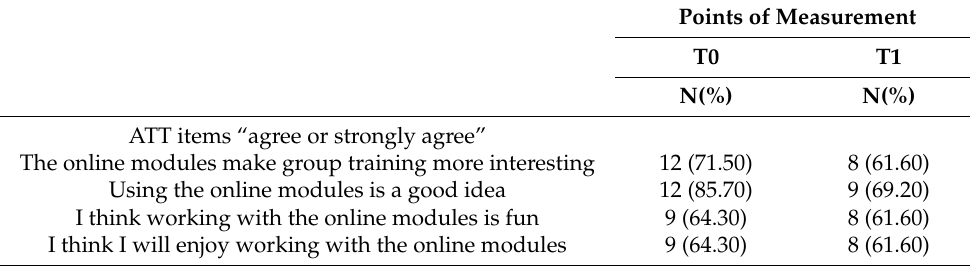
Table 5. Acceptance of digital treatment